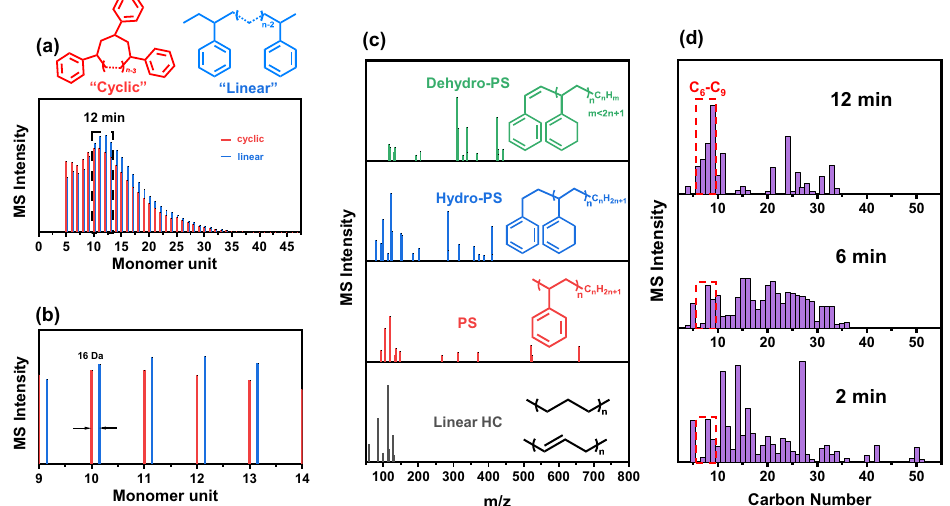
Fig. 2 MS characterization of PS hydrogenolysis liquid products. a MALDI-MS spectrum of PS-12min with Mw ranging from 500 to 5000 Da. Cyclic and linear polystyrenes were represented in red and blue, respectively. b Zoom-in of MALDI spectrum from ( a ), between 9 and 15 monomer units. c Structural classi fi cation of compounds on the ESI-MS spectra for PS-12min as a function of ion mass/charge number (m/z). Linear hydrocarbon (Linear HC, black), polystyrene (PS, red), hydrogenated polystyrene (Hydro-PS, blue), and dehydrogenated polystyrene (Dehydro-PS, green) were identi fi ed and represented. d Comparison of carbon number distribution among PS-2min, PS-6min, and PS-12min.